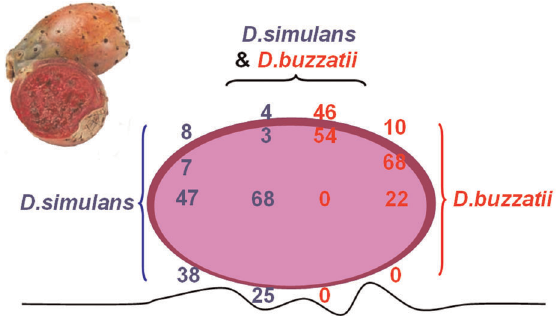
Figure 1. Distribution (percentages) of D.simulans and D.buz- zatii pupae on decaying prickly pear fruits . The pupae were detected inside the fruit, under the skin, over the skin and under the fruit on the land (convoluted line). Number of fruits (N=86) collected with pupae of the two species: D. simulans pupae (N=671); D. buzzatii pupae (N =380). Number of fruits (N= 46) collected with only D. simulans pupae (N=521). Number of fruits (N=47) collected with only D. buzzatii pupae (N=432).